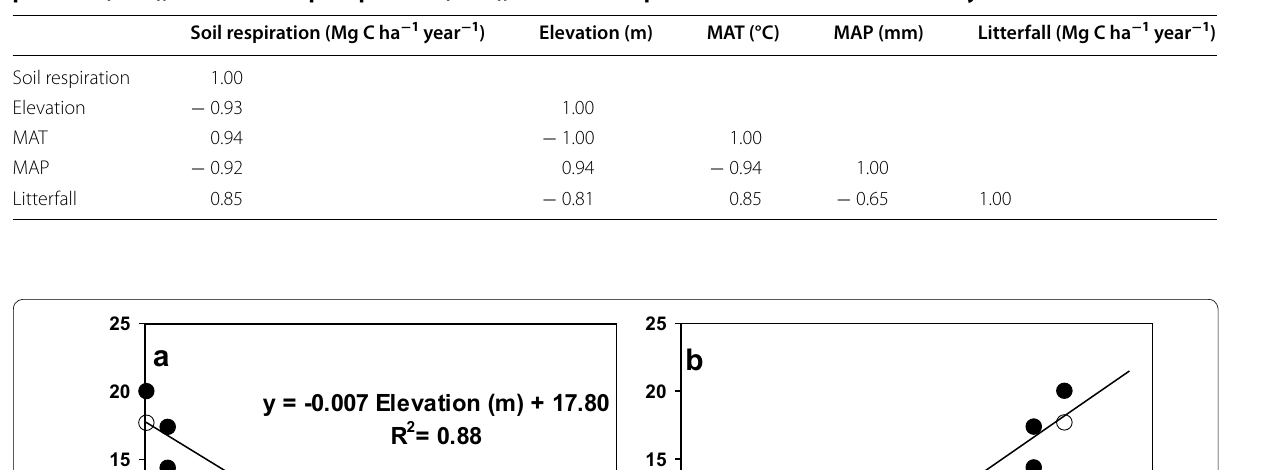
Table 4 Correlation coefficients at significant level p < 0.01 for annual soil respiration rate, elevation, mean annual tem- perature (MAT), mean annual precipitation (MAP), and litterfall production in 10 Taiwanese study stands